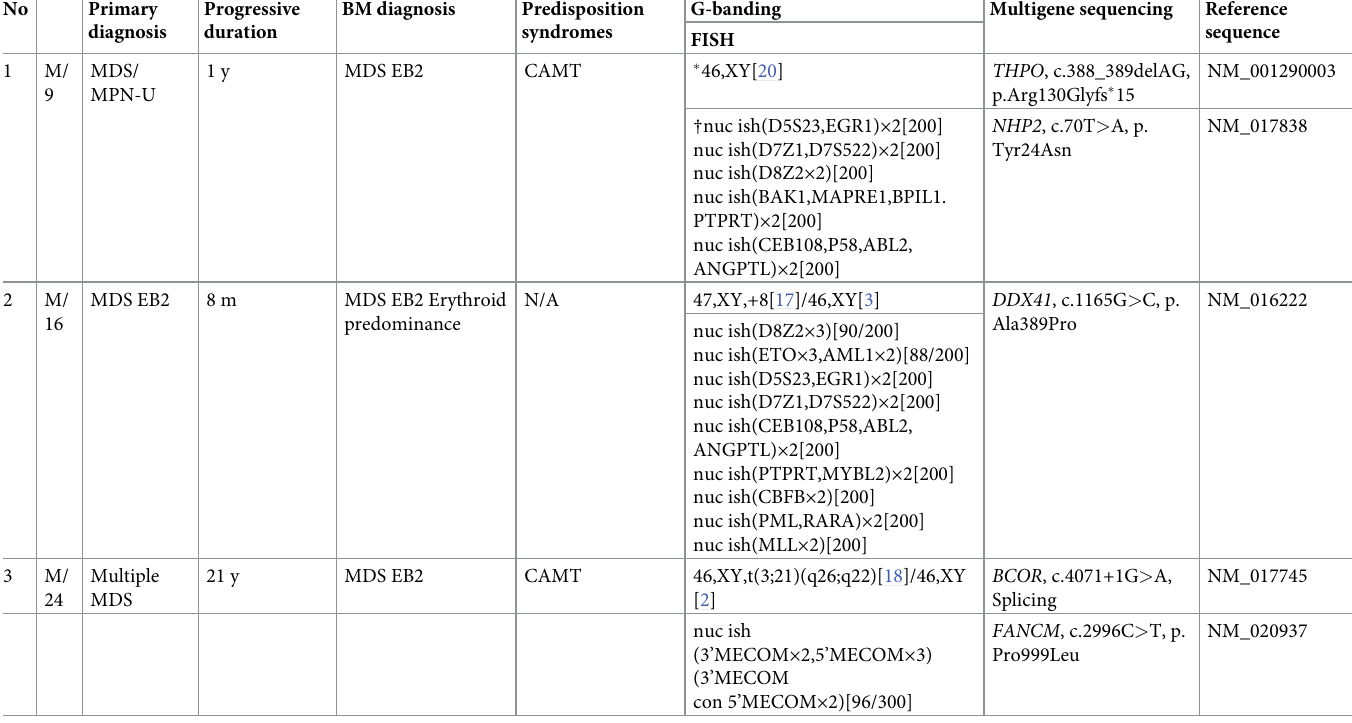
Table 2. Clinical information and bone marrow findings of G-banding/FISH and targeted multigene sequencing in the three patients with myelodysplastic